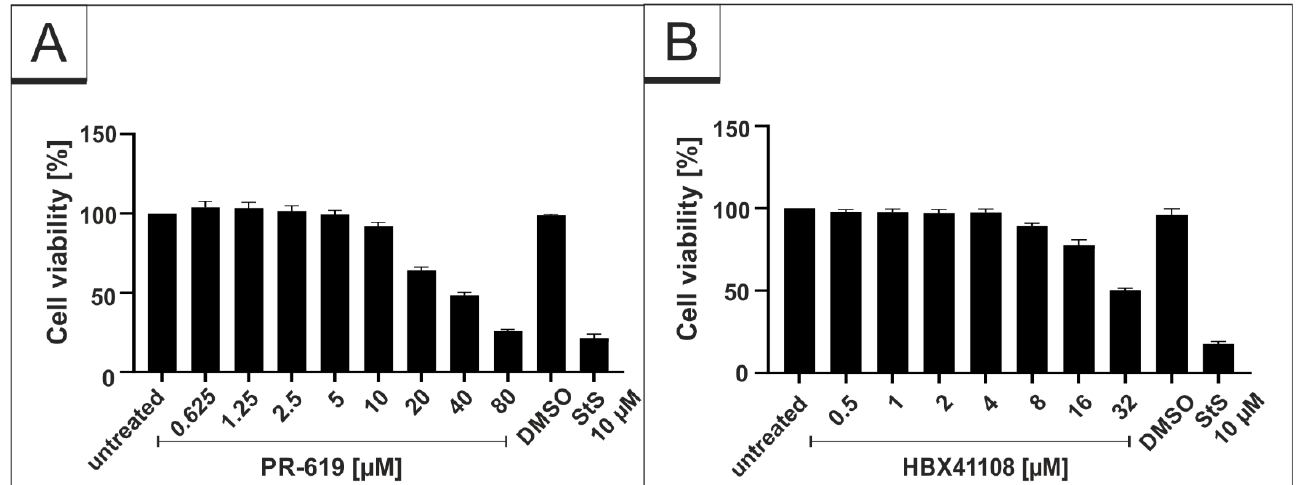
Figure 2. Influence of PR-619 and HBX41108 on cell viability in Vero B4 cells. Following treatment with ( A ) PR-619 and ( B ) HBX41108 for three days, the cell viability was measured by water-soluble tetrazolium salt (WST)-1 assays. Bars represent mean values of three independent experiments ± SD. Staurosporine (StS).